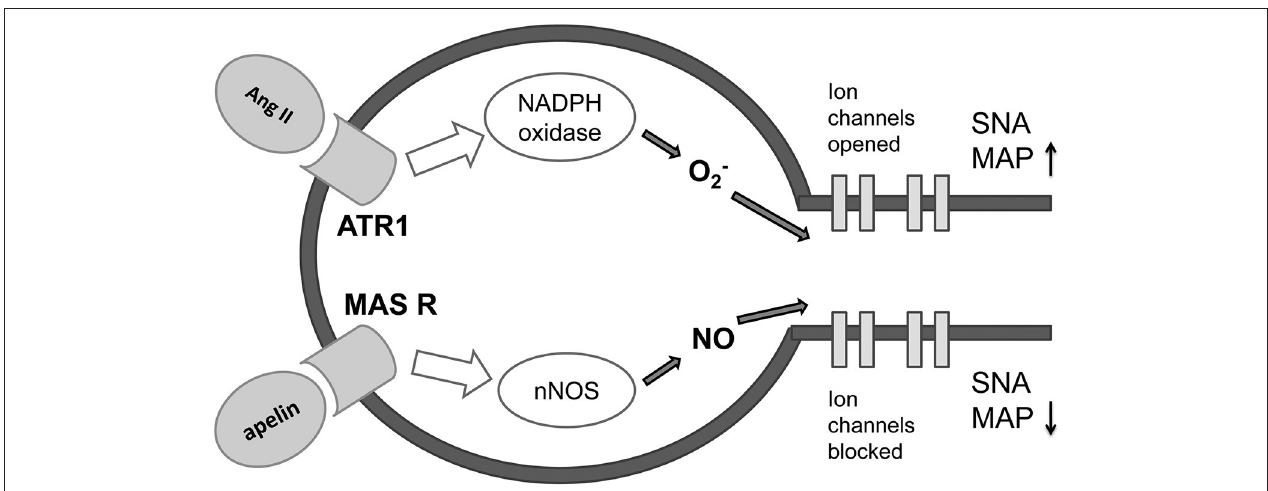
FIGURE 6 | Proposed mechanism of antagonizing effect of apeline-MAS receptor and Angiotensin II-ATR1 molecular signaling pathways on preganglionic sympathetic neurons in the brainstem (adapted from Northrup and Erickson 1992.) Ang II, angiotensin II; ATR1, angiotensin 1 receptor; MAS R, MAS receptor; O2, superoxide; NO, nitric oxide; nNOS, neural nitric oxide synthase; SNA, sympathetic nervous activity; MAP, mean arterial